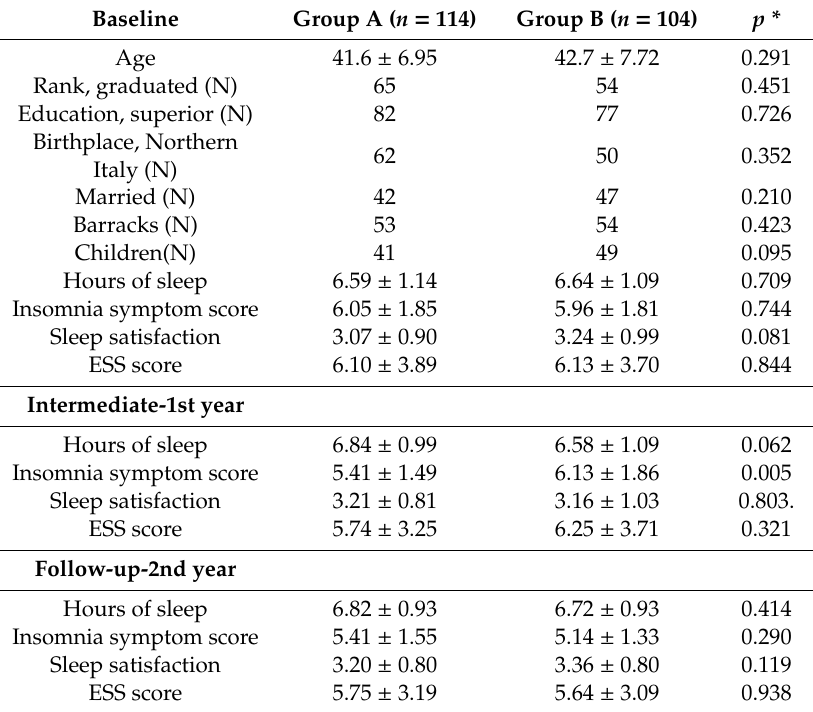
Table 1. Di ff erence between A and B subgroups of workers at beginning, after the first wave of intervention (first year), and at follow-up.